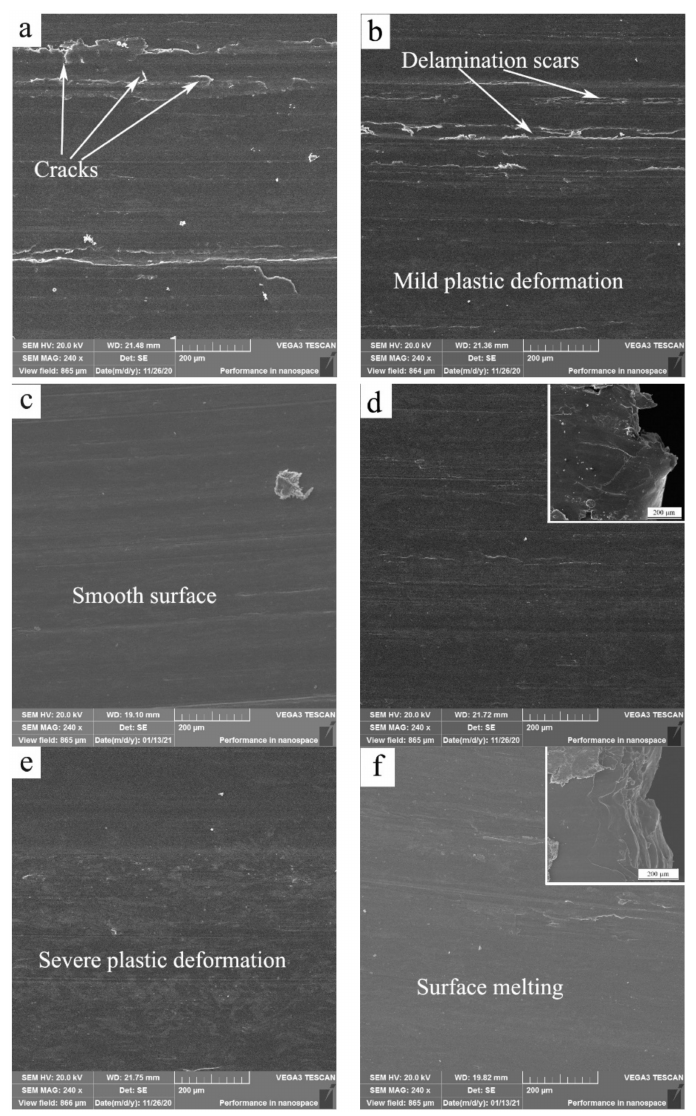
Figure 3. SEM microphotographs of worn surfaces at 50 ◦ C under different loads: ( a ) 20 N, ( b ) 60